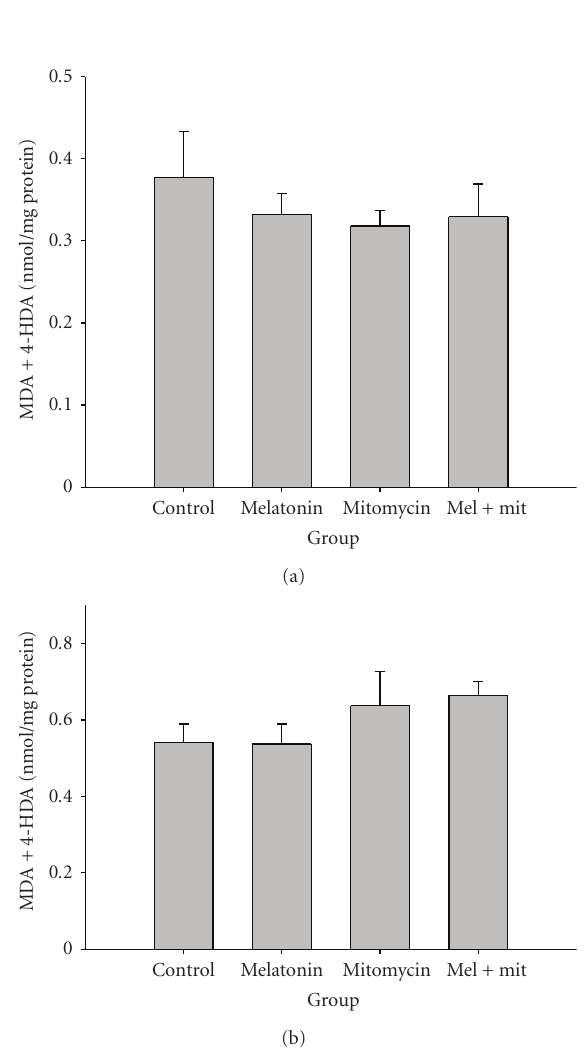
Figure 2: Malondialdehyde (MDA) plus 4-hydroxyalkenals (4- HDA) concentrations in brain (a) and liver (b) homogenates from rats in the presence or absence of treatment with mitomycin C (MMC) or melatonin. Values are mean ± standard